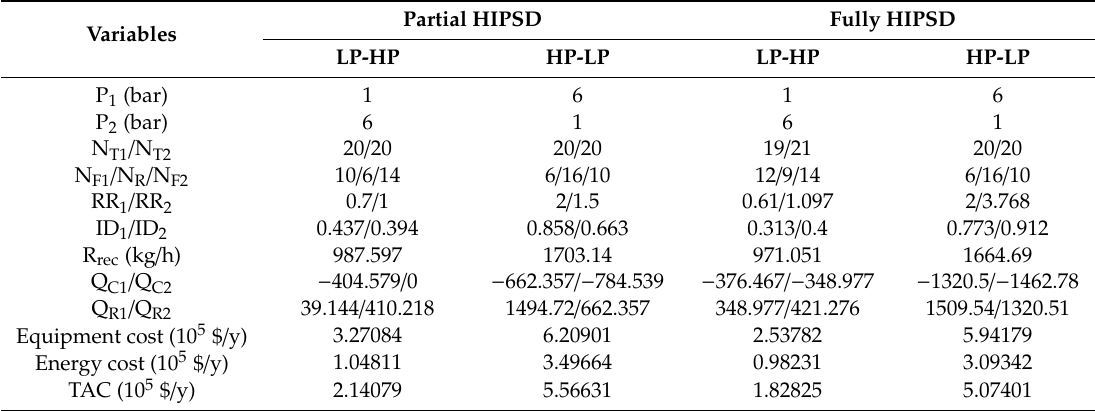
Table 4. Economic comparison for partial and fully heat integrated pressure swing distillation (HIPSD) processes with di ff erent distillation